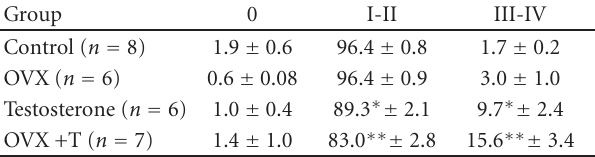
Table 1: Glomerular scores by treatment and